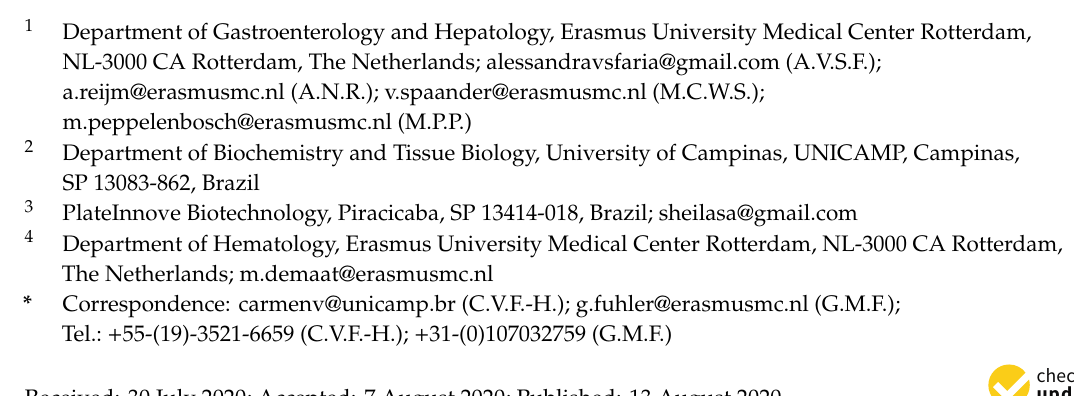
Figure 1 should be replaced with the following, correct